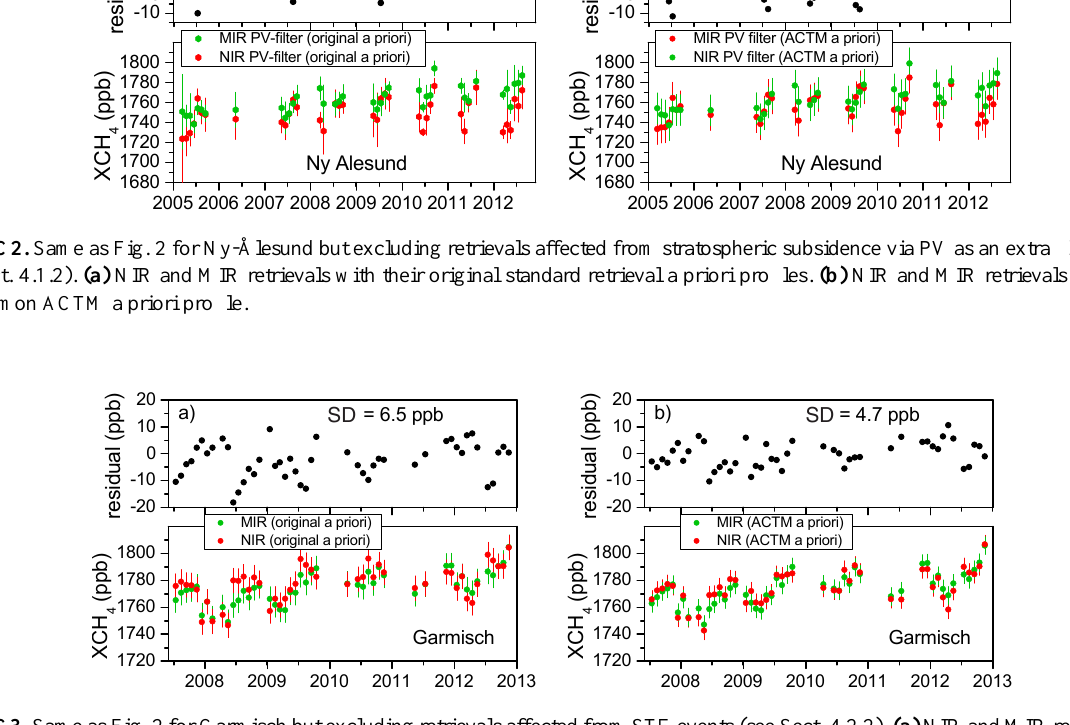
Figure C3. Same as Fig. 2 for Garmisch but excluding retrievals affected from STE events (see Sect. 4.2.2). (a) NIR and MIR retrievals with their original standard retrieval a priori profile. (b) NIR and MIR retrievals corrected to the common ACTM a priori